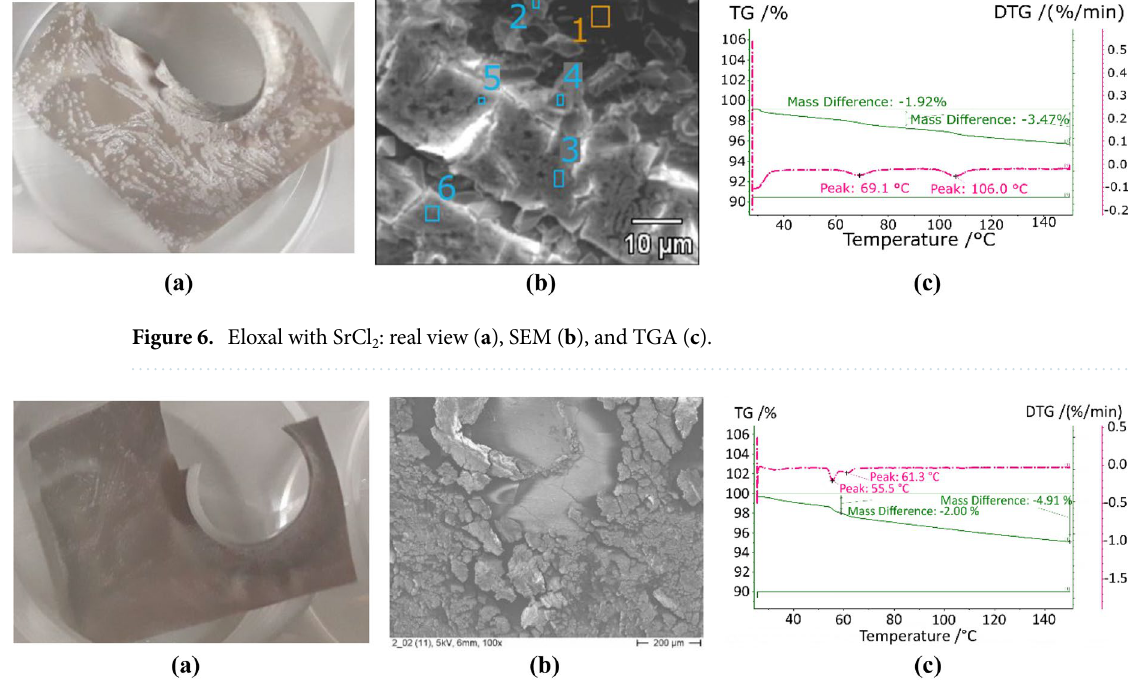
Figure 7. Eloxal with ZnSO 4 : real view ( a ), SEM ( b ), and TGA ( c